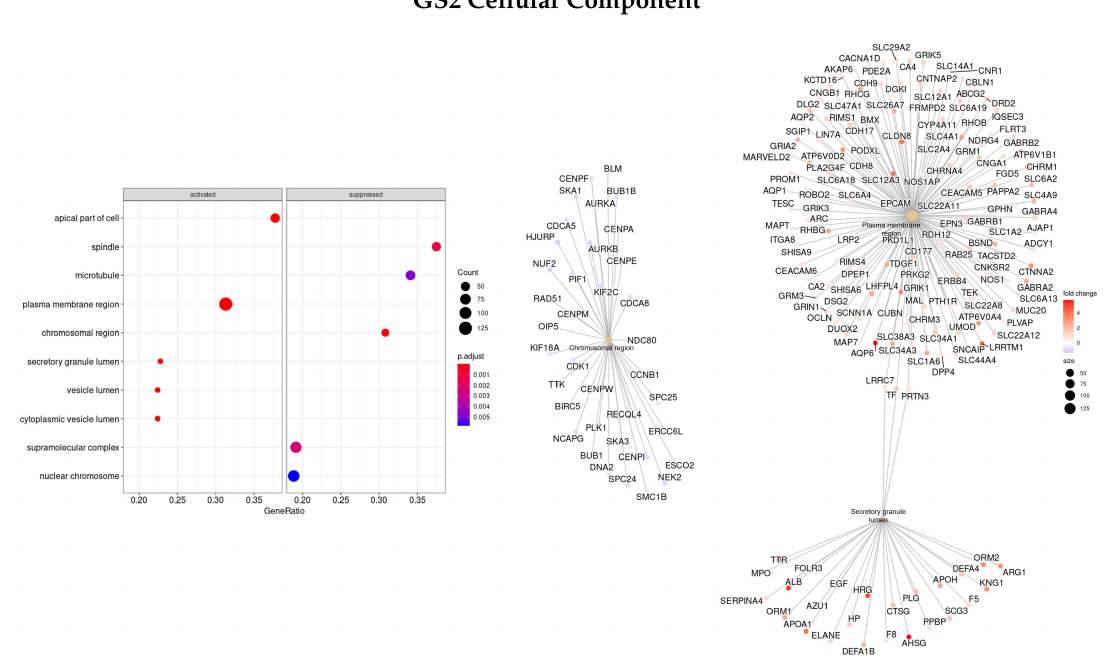
Figure 6. Gene ontology enrichment analysis regarding cellular components terms for a list of DEGs ranked by the log fold change between early and advanced stages of the disease. The left panel shows a dot chart with the most significant CC terms. The right panel shows a gene-concept network plot of the three most enriched terms that depicts the linkages of genes and biological concepts as a